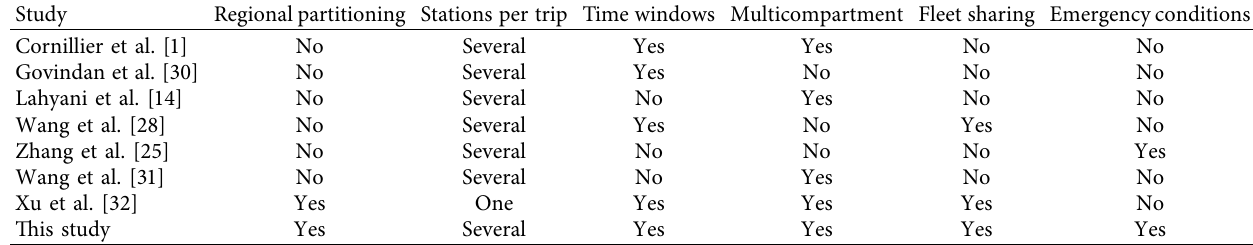
Table 1: Comparison between existing literature and the present study.